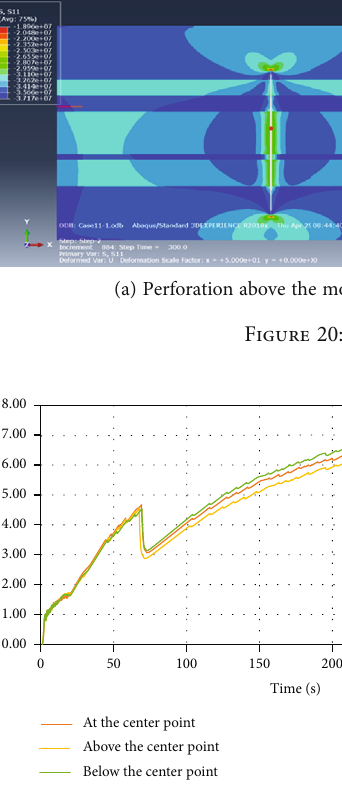
Figure 21: The in fl uence of the perforation position on injection pressure and fracture